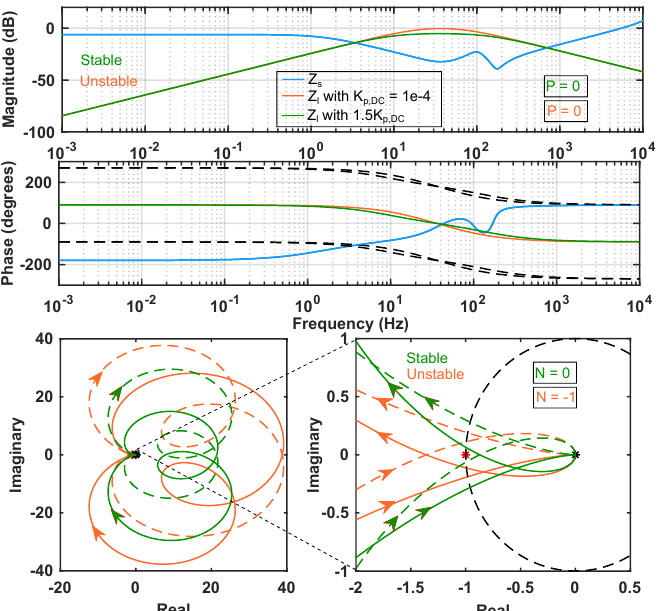
Figure 24. Star with 9 WTs—Impact of DC/DC converter proportional gain on system stability at P 3 .